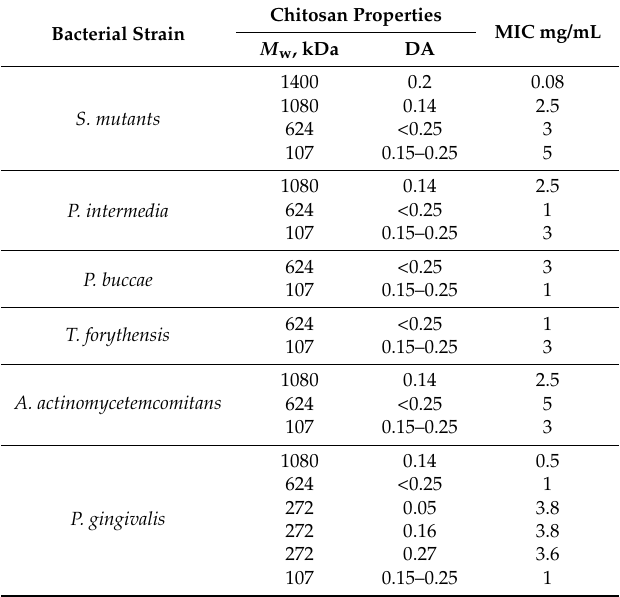
Table 5. Effect of chitosan M w and deacetylation degree on minimum inhibitory concentrations (MIC) against oral pathogens